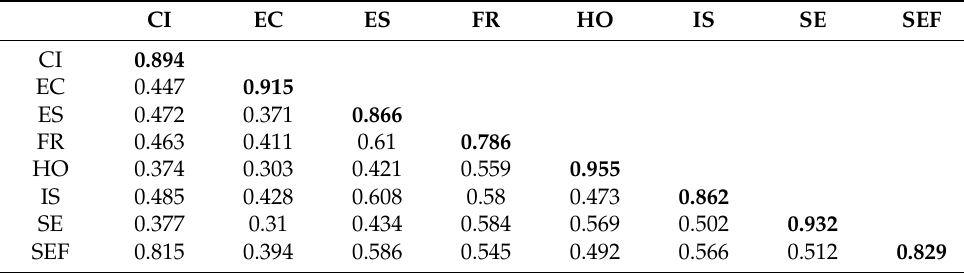
Table 5. Discriminant validity results of the measurement